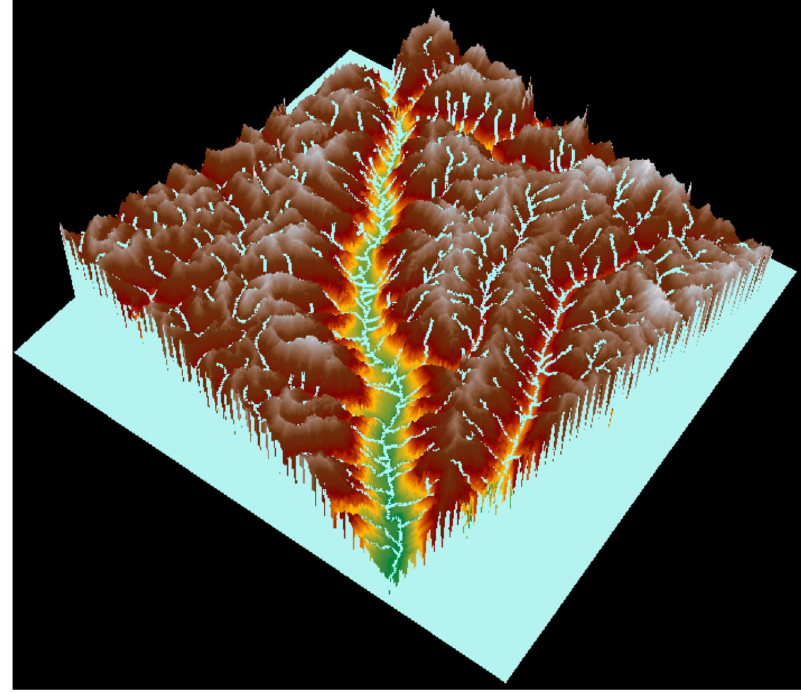
Figure 6. The channels were vectorized and exported in 3D view with DEM. The streams with Strahler Order < 3 were excluded. The elevation range is from 2150 to 5040 m. The approximate size of the domain is about 1400 km 2